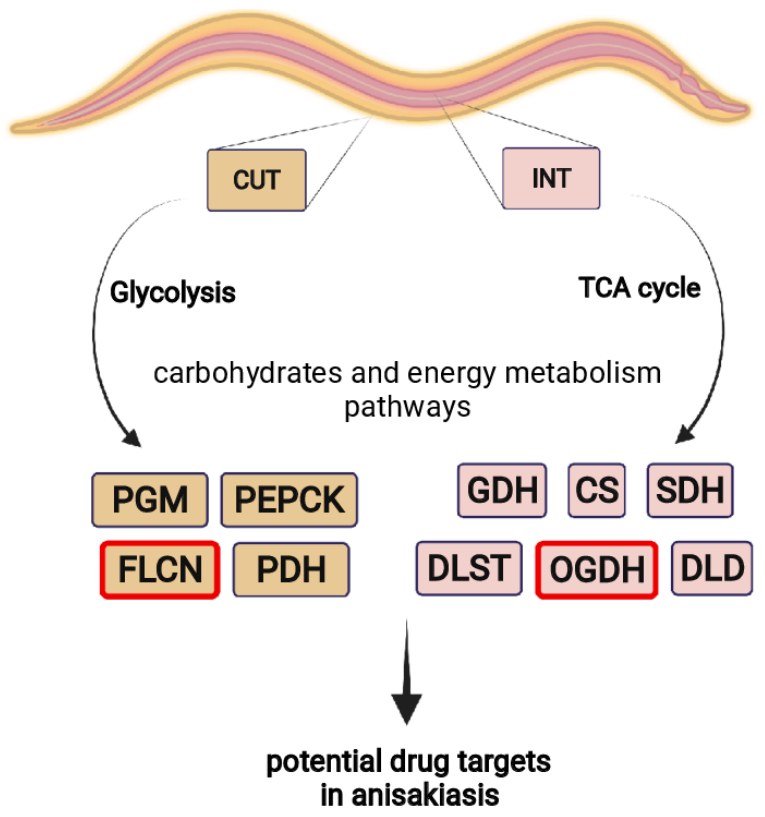
Figure 8. Summary of the results discussed. The possibility of using enzymes of energy and carbohydrate metabolism as potential drug targets in